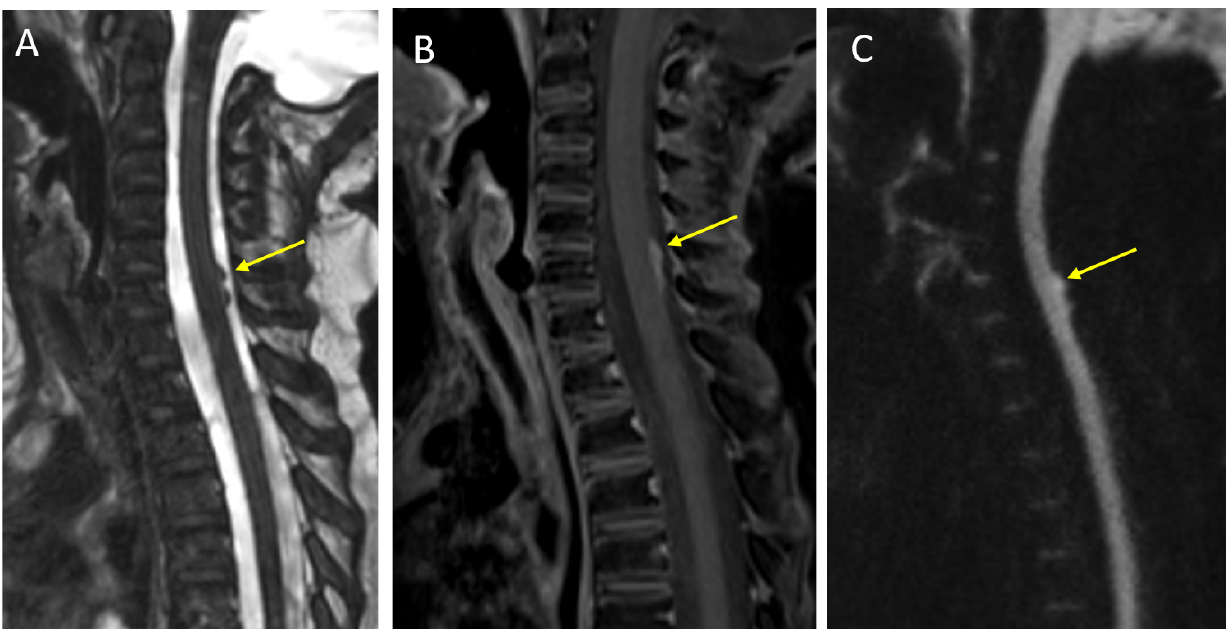
Figure 2. A 6-year-old girl with leptomeningeal metastasis from medulloblastoma. Sagittal CISS ( A ) and post-contrast T1 ( B ) imaging demonstrate nodular and enhancing metastatic foci along the dorsal cervical spinal cord (arrows). DWI ( C ) imaging shows associated diffusion restriction. Classically, medulloblastomas have been considered as midline posterior fossa le- sions arising from the medullary vellum and compressing the fourth ventricle. However, these tumors are known to occur eccentrically as well. The variability in appearance and location reflects the heterogeneous molecular pathology of these tumors. Traditionally, these tumors have been classified into four histological types: classic medulloblastoma,